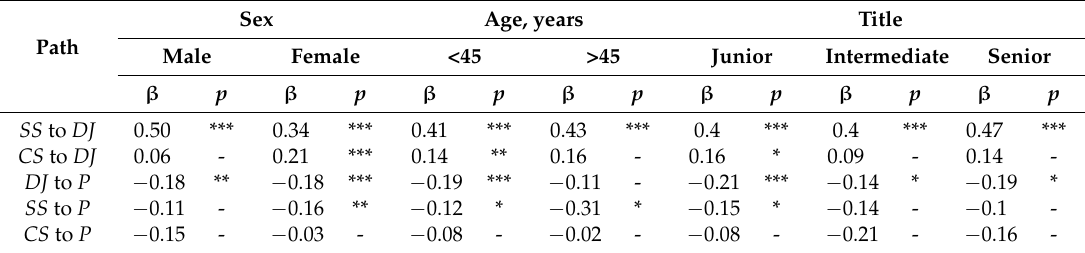
Table 3. Standardized regression weights (β) with p-values (α = 0.05) for the components of subgroup analyses.